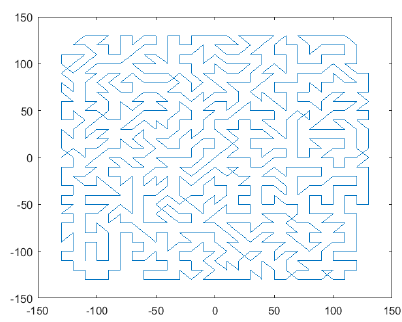
Figure 6. Results of the pseudo-random path under the polishing path width of 10 mm.